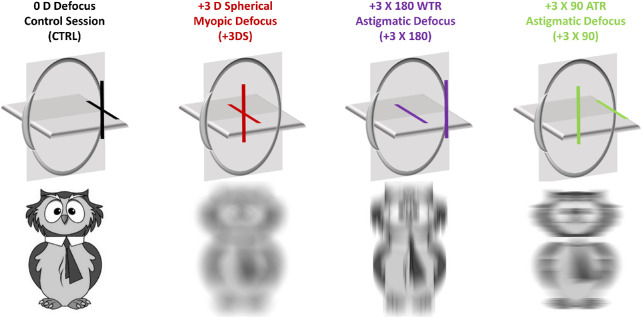
Schematic diagram of the position of vertical and horizontal focal planes relative to the retina across the four experimental sessions (top row), and simulation of the effect of each of the defocus conditions over a cartoon image (bottom row). The right eye was optimally corrected using sphero-cylindrical trial lenses during each experimental session and was only occluded briefly (∼1–2 minutes) during the OCT imaging of the left eye.